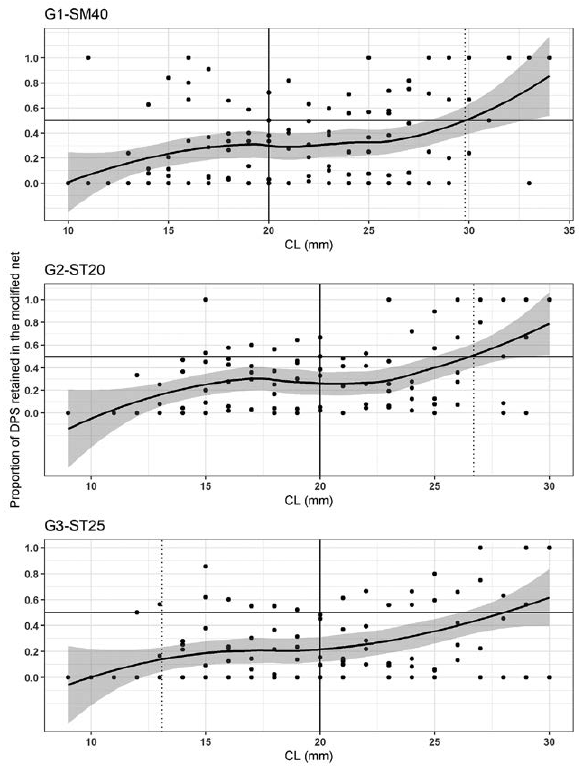
Fig. 4. – Proportion of fish retained in trawl nets equipped with JT- EDs (=JTED/(JTED+ control) vs. length for deep-water rose shrimp (DPS). The value of 0.5 means both gears catch equal numbers,the solid line gives the mean, and the grey band gives the 95% confi- dence limit. MCRS (DPS, 20 mm; HKE, 20 cm). G1-SM40, JTED covered with a net of 40-mm square mesh; G2-ST20, JTED with steel bars spaced 20 mm; G3-ST25, JTED with steel bars spaced 25 mm.